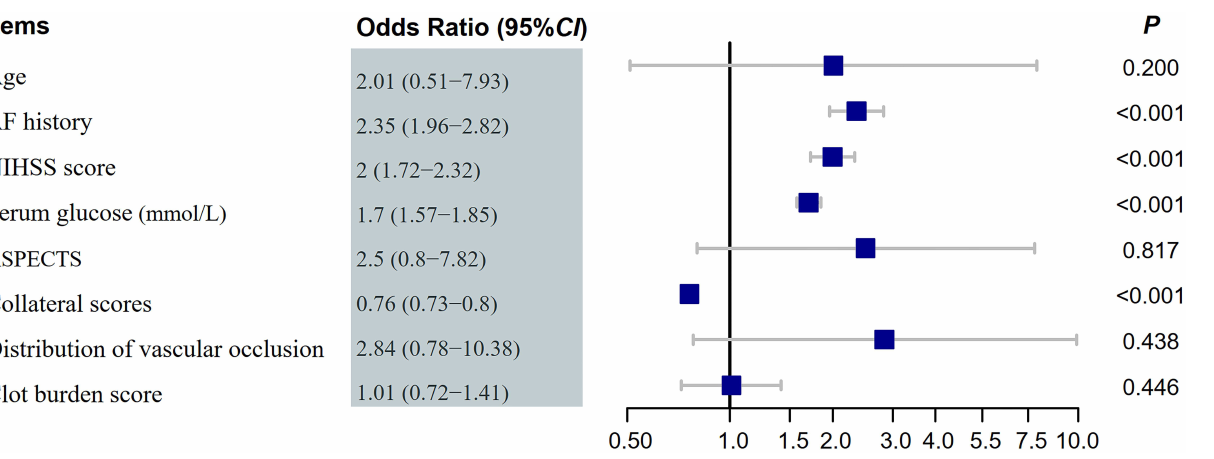
FIGURE 3 | Forest plot of hemorrhage transformation after endovascular treatments. NIHSS, National Institute of Health Stroke Scale; AF, atrial fibrillation; ASPECTS, Alberta stroke program early CT score; OR, odds ratios.